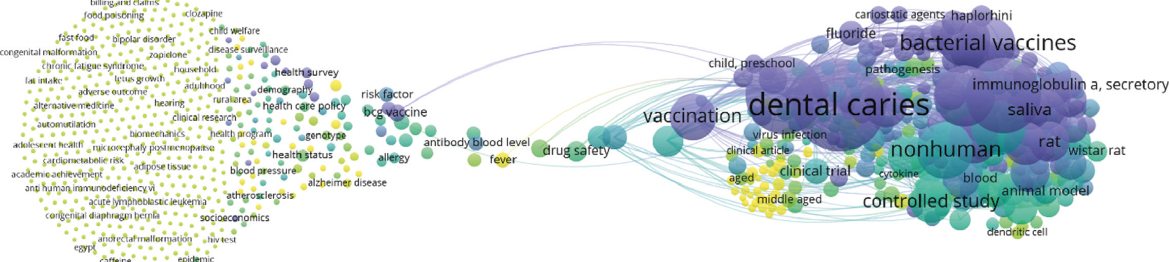
Figure 3: Synthetic knowledge